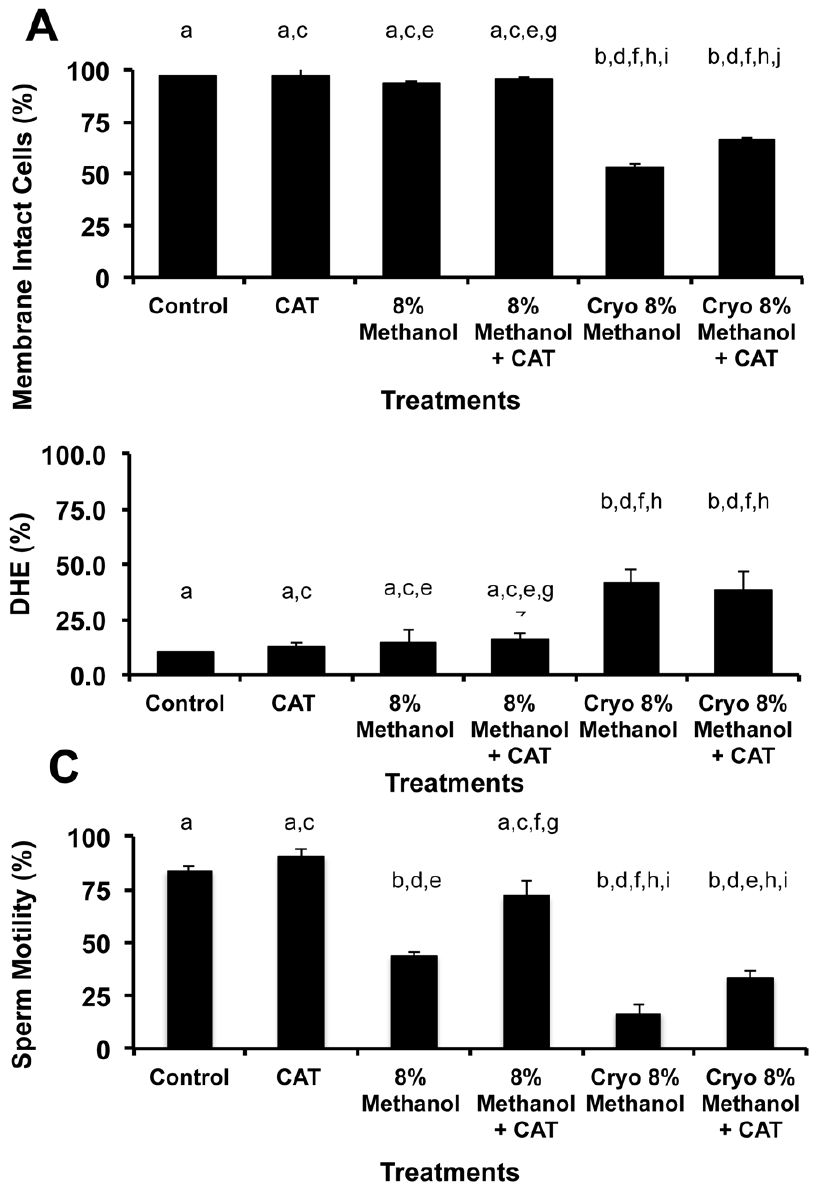
Figure 3. Evaluation of the intracellular ROS in zebrafish spermatozoa during cryopreservation and its effect on viability and motility. ( A ) Overall, cryopreservation decreased the viability of zebrafish sperm by approximately 50%, but the addition of CAT to the methanol improved its post-thaw viability 16% (P , 0.05, ANOVA and Tukey’s Multiple Comparison test, F=60.5). ( B ) Cryopreservation increased ROS over 2.7- fold (P , 0.05, ANOVA, and Tukey’s Multiple Comparison test F=6.2), but the addition of CAT did not mitigate it (P . 0.5, ANOVA). ( C ) Motility demonstrated the greatest sensitivity in our treatments. Prior to cryopreservation, the 8% methanol treatment reduced motility by , 50%, and the addition of CAT to the 8% methanol returned the motility to control levels. In parallel, the cryopreserved sperm (8% methanol) decreased the pot- thaw motility of zebrafish sperm from 83% (control) to 17%, however the addition of CAT doubled this post-thaw motility (P , 0.05, ANOVA and Tukey’s Multiple Comparison test, F=22.6). Bars with the same letter are not significantly different (P . 0.05), but bars with different letters are (P , 0.05). X- axis categories and sample sizes were: Control= live sperm stained with DHE, N=13; CAT (200 U/ml, concentration used in all CAT treatments), N=9; 8% Methanol, N=12; 8% Methanol + CAT 200, N=12; Cryo 8% Methanol = sperm cryopreserved according to [6] with 8% methanol, N=13; Cryo 8% Methanol + CAT, N=13.